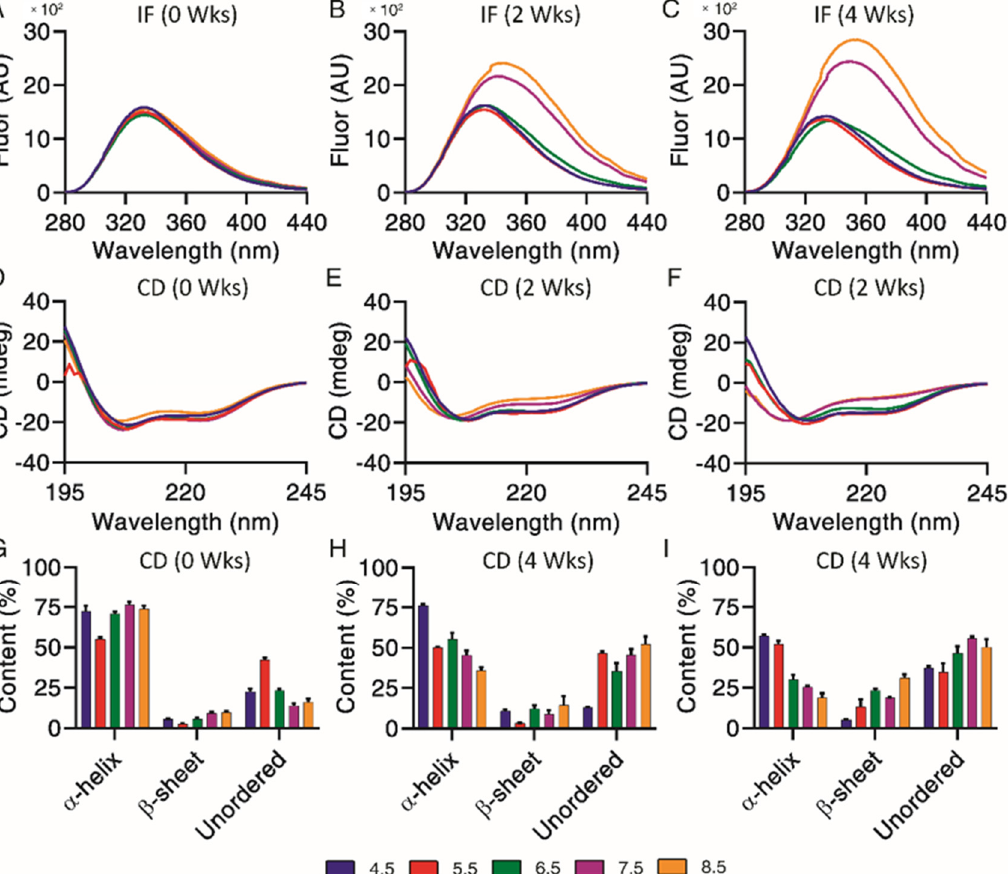
Figure 4. Structural and conformational changes characterized and measured by ( A – C ) intrinsic fluorescence and ( D – F ) circular dichroism, with secondary structures ( G – I ) quantified by CDPro analysis ( n = 3, mean ± SEM) for exe- natide that was reconstituted at pH 4.5–8.5 after incubation at 37 ◦ C for 4